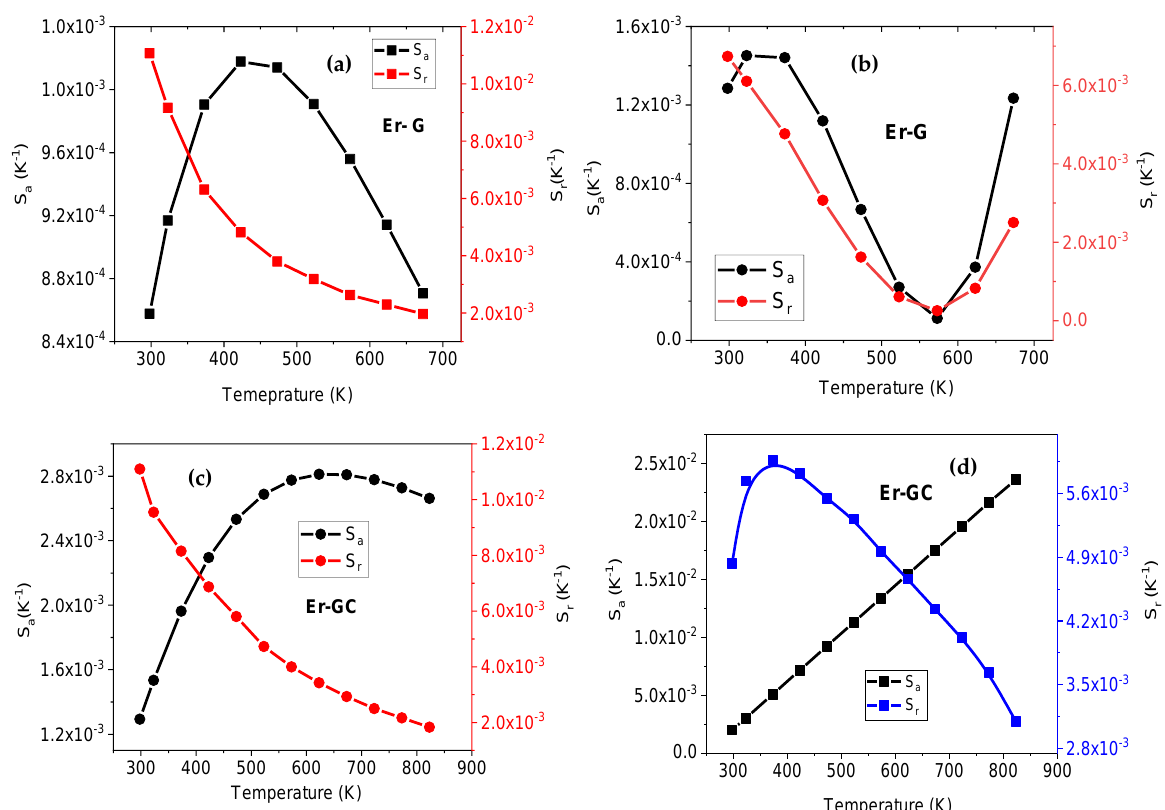
Figure 12. Absolute and relative temperature sensitivity versus temperature: ( a , c ) are TCLs of Er 3+ in Er-G and Er-GC and ( b , d ) are NTCLs of Er 3+ in Er-G and Er-GC, respectively. Table 2. Values of the maximum absolute sensitivity, Sa , and relative sensitivity, Sr , at starting temperature, energy spac- ing (∆E), experimental temperature ranges of different Er 3+ and Er 3+ /Yb 3+ co-doped materials using the fluorescence inten- sity ratio (FIR) method based on the green emissions of the Er 3+ ion.